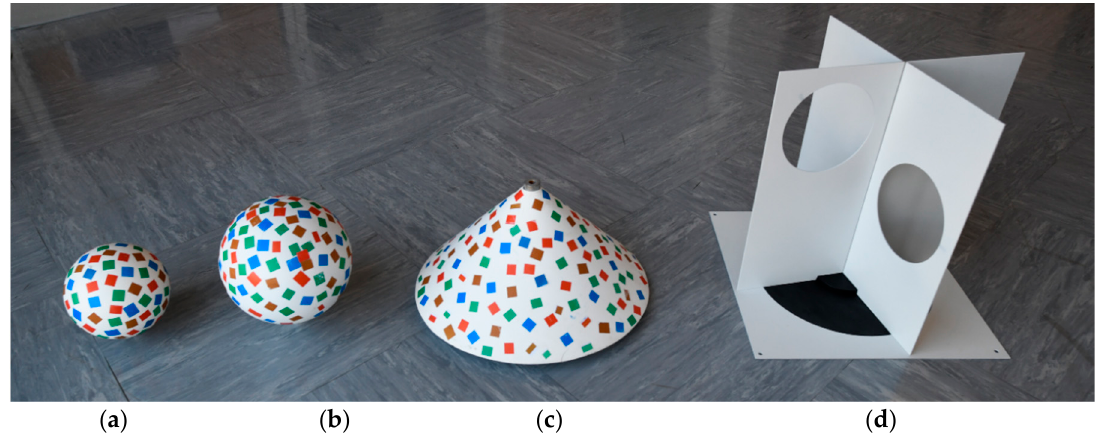
Figure 8. Volume targets for registering TLS and UAV point clouds: ( a ) Small sphere; ( b ) large sphere; ( c ) cone; ( d ) new target.